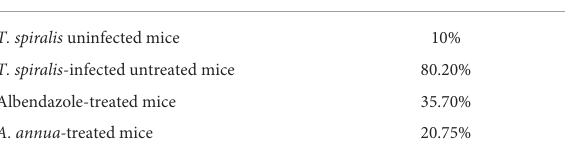
TABLE 1 Percentage (%) of TGF- β positive cells in the intestinal tissue of different groups of mice. Groups TGF- β positive cells